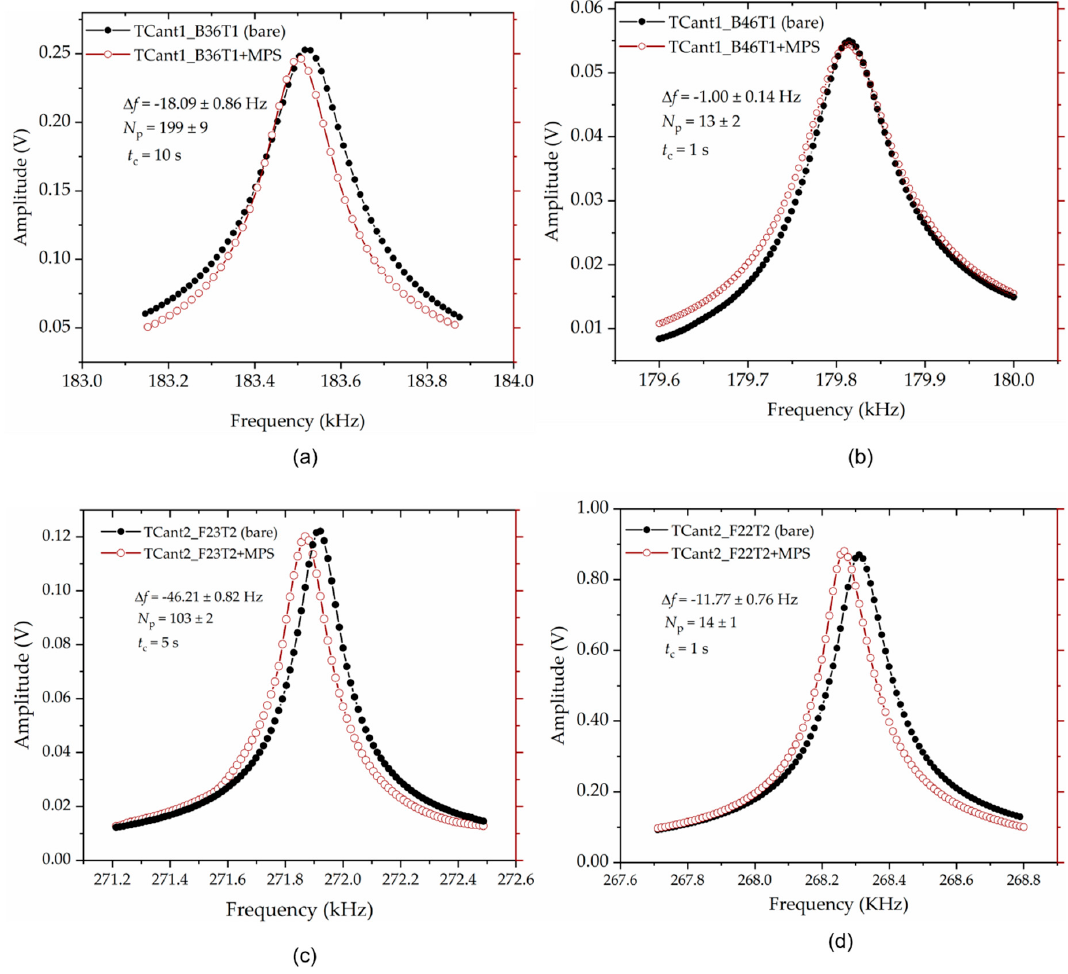
Figure 12. Plot of the resonant frequency responses before and after adsorbing magnetic polystyrene (MPS) microparticles on assorted fabricated triangular cantilevers. ( a , b ) denote measurements from TCant1 cantilever sensors, while ( c , d ) are measurements from TCant2 cantilevers. The MPS µPs (whose number N p —determined based on point mass-condition i.e., from Equations (2) and (3)) were deposited on the sensing area through the particle-imprint approach by observing tip-sensor-contact time t c of about 10 s, 5 s, and 1 s using stainless steel tips with nominal internal diameters of ∼ 0.10 mm ( a , c , d ) and ∼ 0.15 mm ( b ).